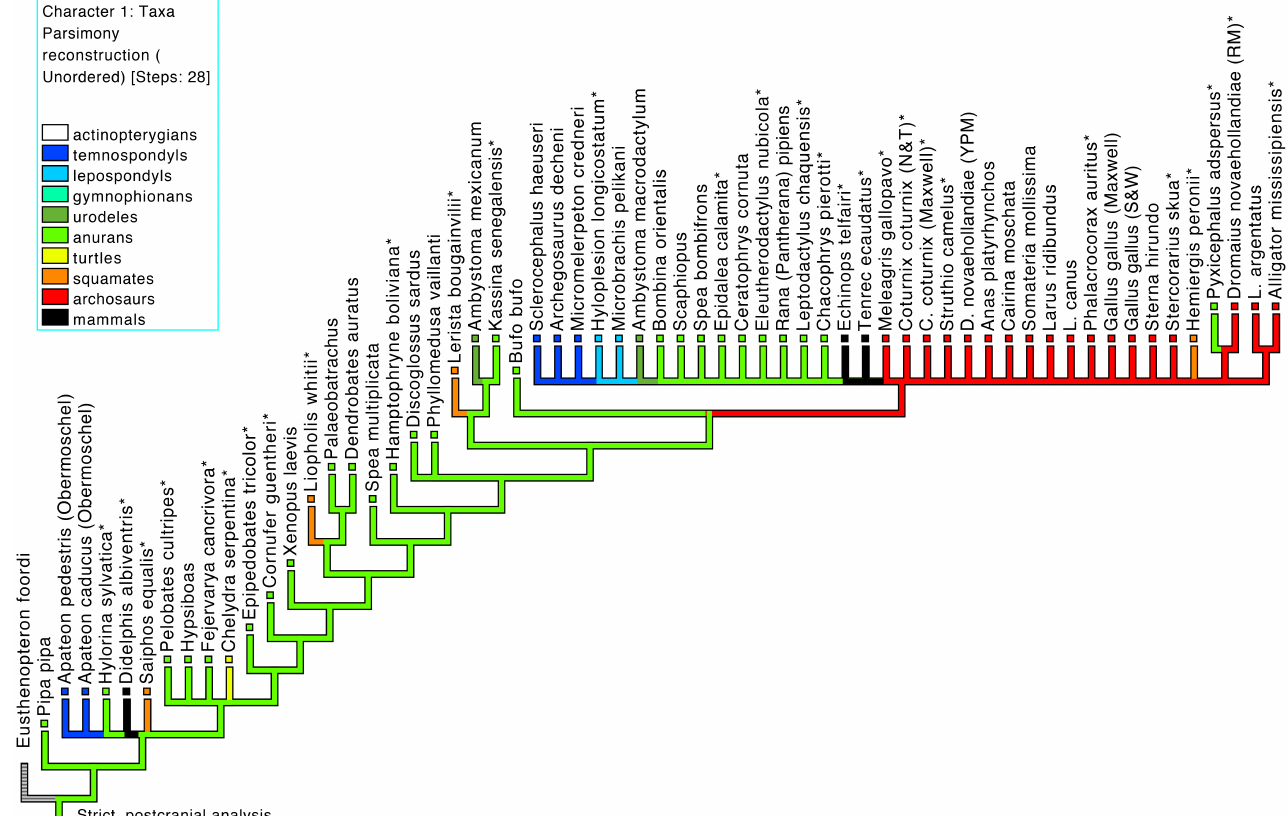
Figure 4 – Strict consensus of the most parsimonious trees obtained by analyzing ap- pendicular dataset 3. Dataset 3 comprises 62 taxa and seven characters (see Table 1). The phylogenetic signal in these data seems to be lower than in the cranial data. See Fig. 3 for